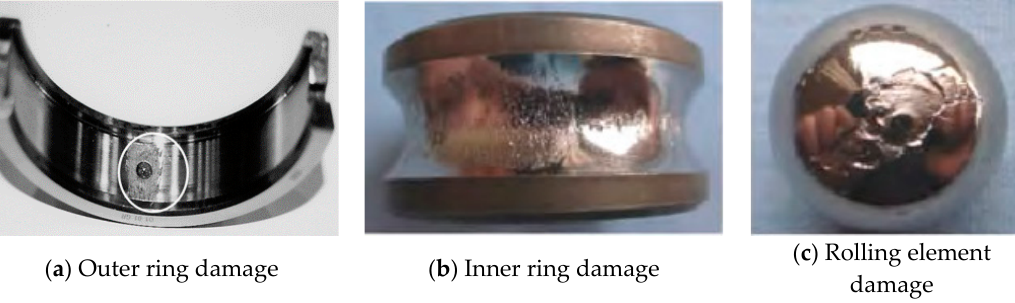
Figure 7. Photographs of three kinds of damaged bearings.